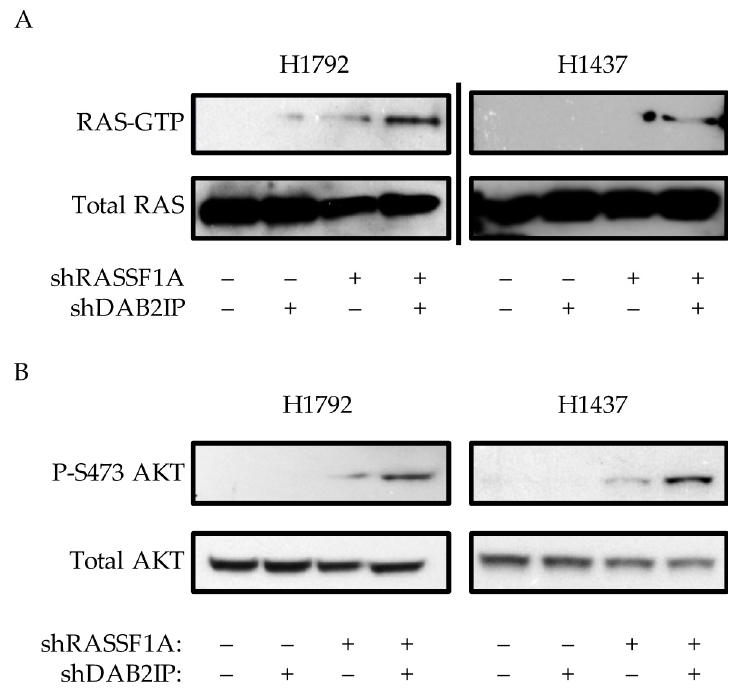
Figure 3. Effects of RASSF1A and DAB2IP suppression on RAS activity. ( A ) Active RAS pulldown assay on stably transfected NCI-H192 and NCI-H1437 knockdown cells, representative assays shown. ( B ) Western blot analysis of PI3K-AKT pathway activation. Representative assays shown of at least two independent